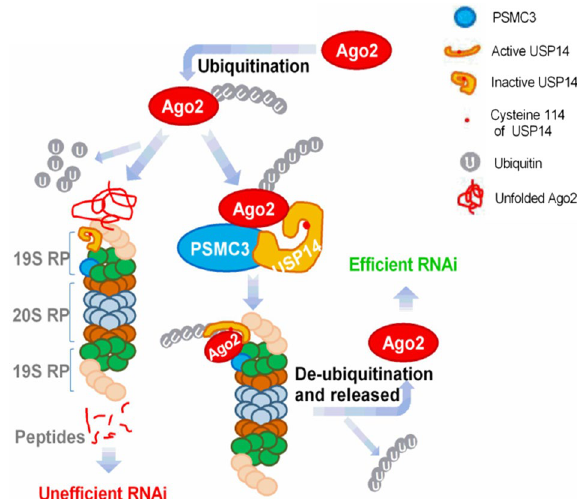
Fig. 6 A model for PSMC3 function in AGO2-dependent RNAi. The ubiquitinated AGO2 protein is